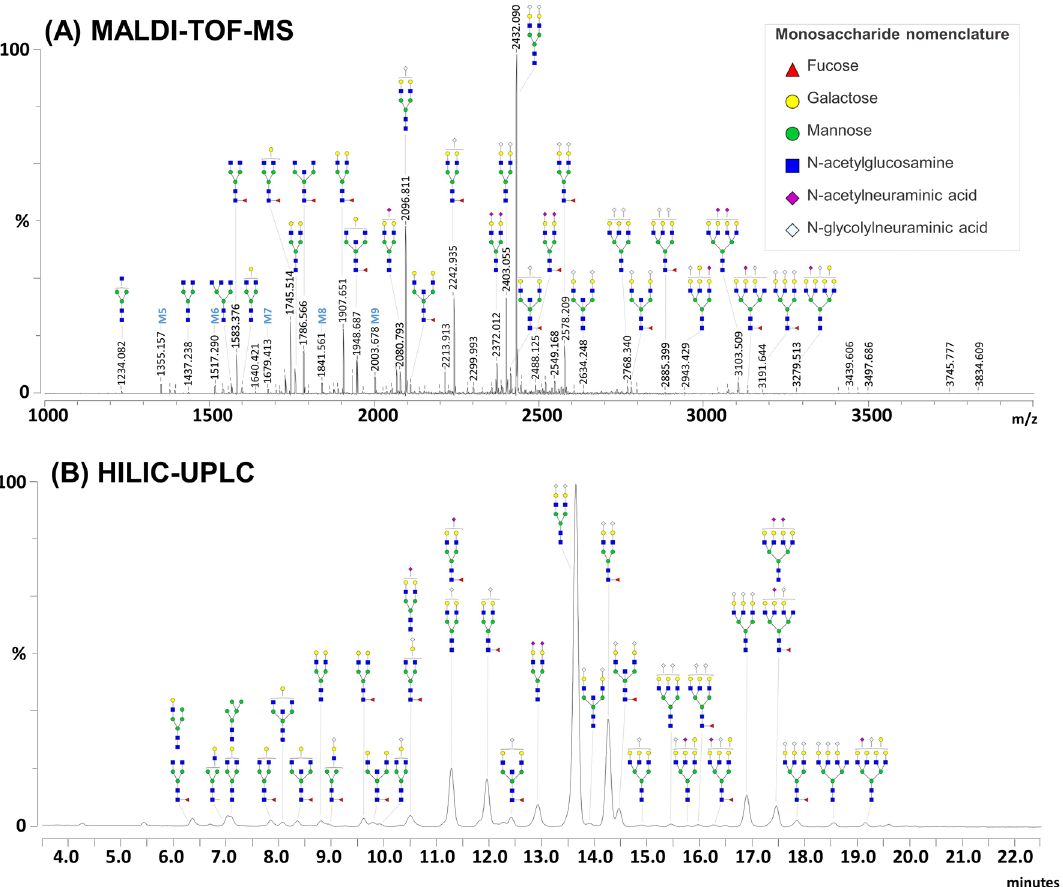
Figure 1. MALDI-TOF-MS analysis and HILIC-UPLC profiling of rhesus macaque serum N-glycans. PNGase F-released glycans from rhesus macaque serum glycoproteins were labeled with 2-AA and analyzed by MALDI- TOF-MS ( A ) or labeled with procainamide and analyzed using HILIC-UPLC ( B ). N-glycans were subjected to linkage-specific derivatization of the sialic acids by ethyl esterification prior to labeling with 2-AA for MALDI- TOF-MS. MALDI-TOF-MS signals were measured in negative ion reflectron mode and are labeled with monoisotopic masses (see Supplementary Table S1 and Fig. S1 online). N-glycan structures were assigned by combining data from both approaches and by using glycosidase digestions (see Supplementary Figs. S2 and S3 online). Proposed structures resulting from this analysis are depicted for selected peaks using the Consortium for Functional Glycomics (CFG) nomenclature (see symbol key inset). M5 to M9 designate mannosylated N-glycans with 5 to 9 mannose